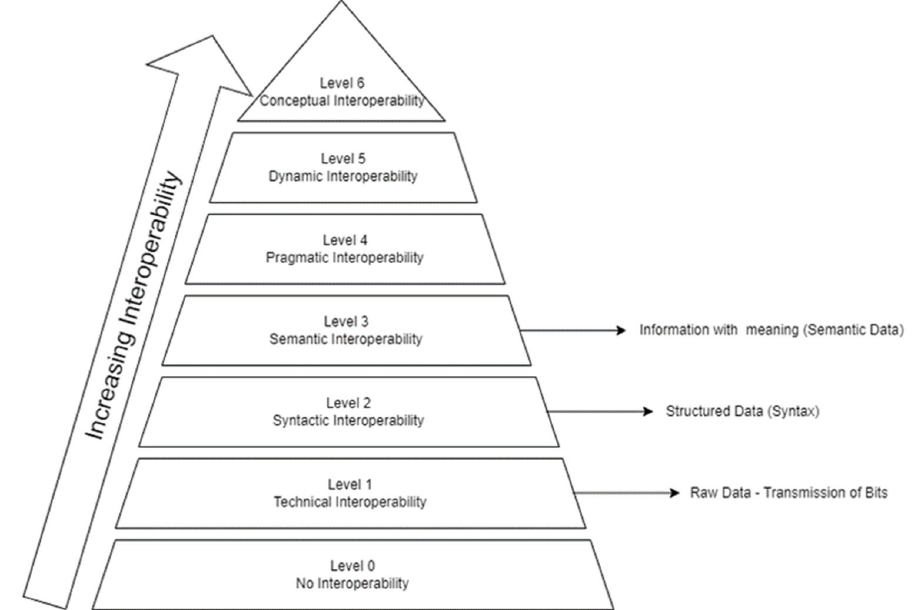
Figure 2. Levels of Interoperability.